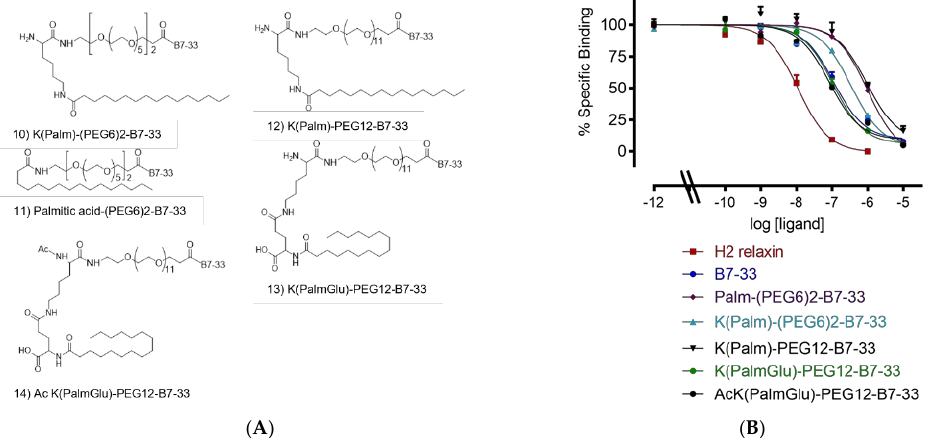
Figure 4. Primary structure and sequence of lipidated analogues. ( A ) Primary structure and se- quence of lipidated analogues with different lengths of spacer used between the fatty acid and B7-33. ( B ) Eu-H2 relaxin competition binding of lipidated analogues in HEK-7BP cells. The data are the result of n = 3 –4 independent experiments and expressed as mean ± SEM.